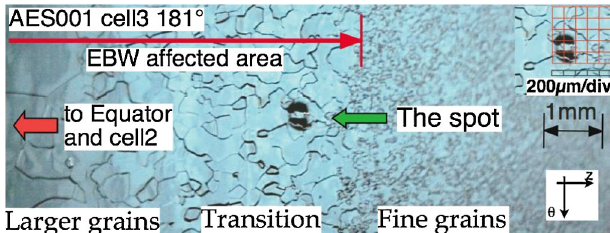
FIG. 11. (Color) Stripe illuminator. The mirror is located under the hole between the two stripes numbered #1 and (cid:1) 1 . The 14 stripes can be independently turned